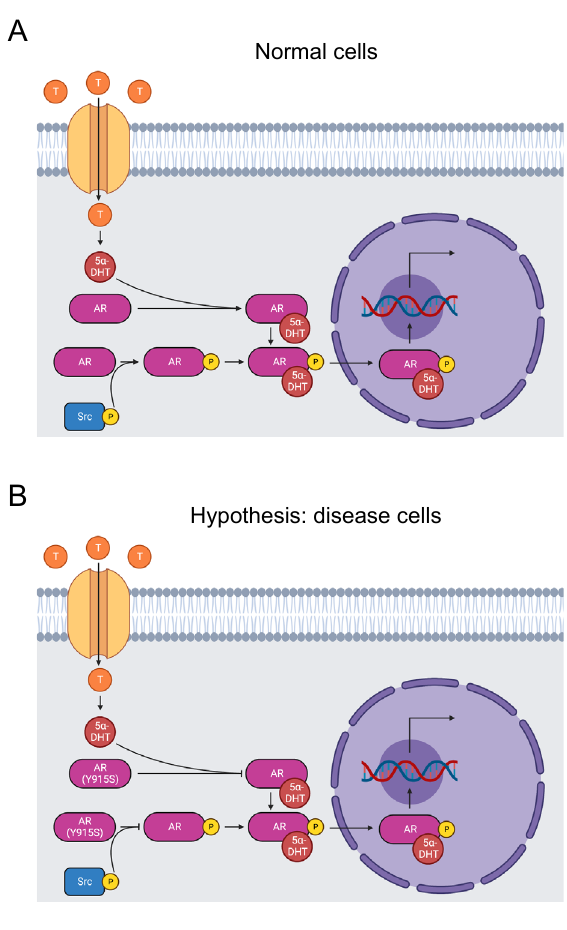
Figure 2. Diagram of the AR signaling pathway. ( A ) Testosterone enters prostate cells, where it converts to 5 α -dihydrotestosterone. It binds to and activates the AR, which is phosphorylated on its ligand-binding domain by a Src kinase. The AR translocates to the nucleus and stimulates RNA transcription that promotes male sexual development [66]. Tyrosine phosphorylation by Src kinases can also activate the receptor independent of androgen binding [67]. ( B ) The mutation Y915S may cause AIS by abolishing tyrosine phosphorylation of the residue and disrupting androgen-independent AR activation. Alternatively, Y915S causes AIS by inhibiting androgen binding to the AR [23,24].